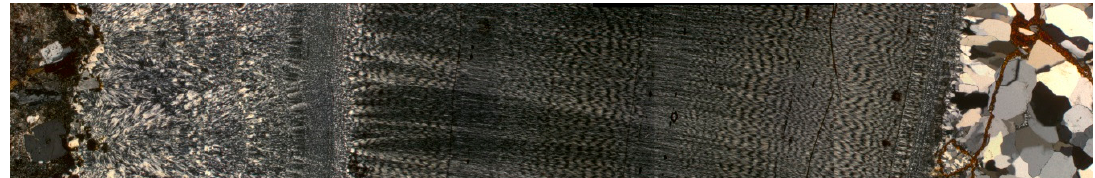
Figure 8. Cross section of a wall-lining agate from Wiederau (Saxony, Germany) from margin (left) to the center (right) in transmitted light (crossed polars) representing the general textural succession of spherulitic and micro-granular chalcedony—fibrous chalcedony—macrocrystalline quartz (width of the micrograph is 10 mm).